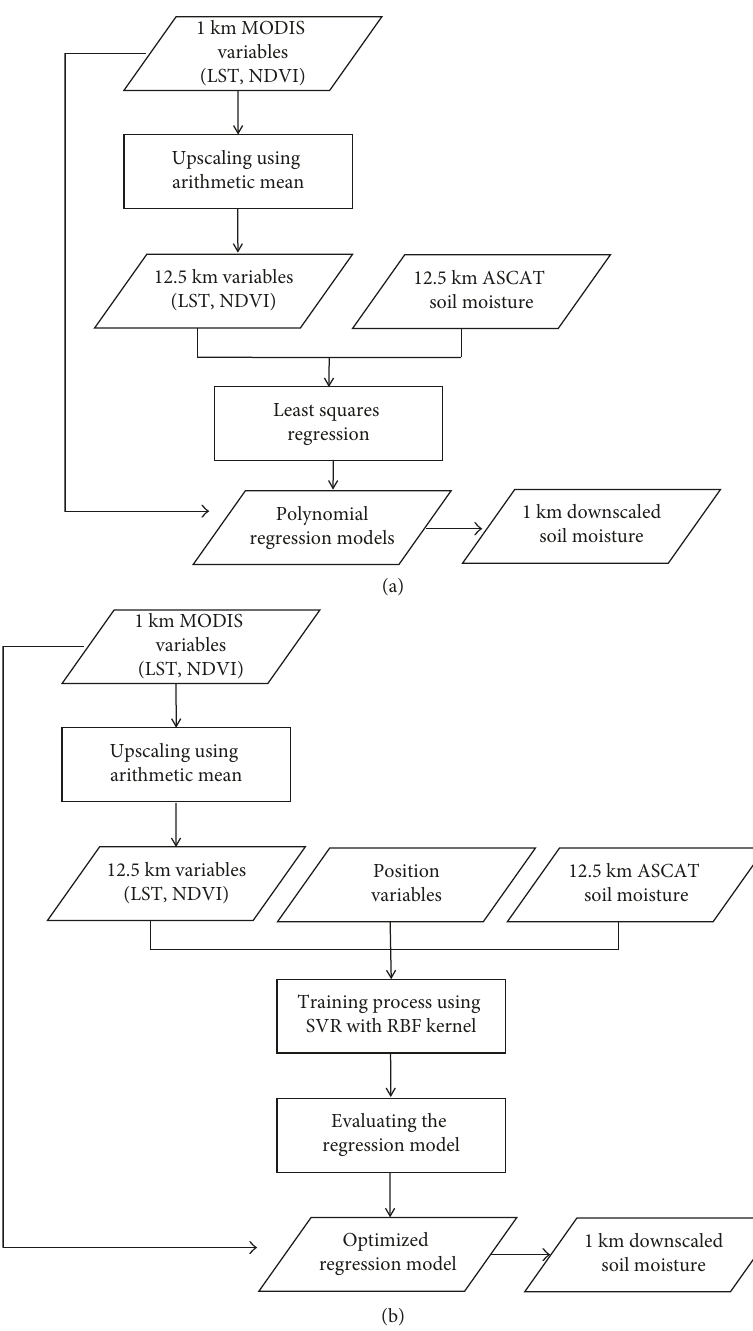
Figure 2: Flow charts of (a) the conventional and (b) the support vector machine (SVR) downscaling Table 3: Parameter characteristics of the SVR regression model. Parameter